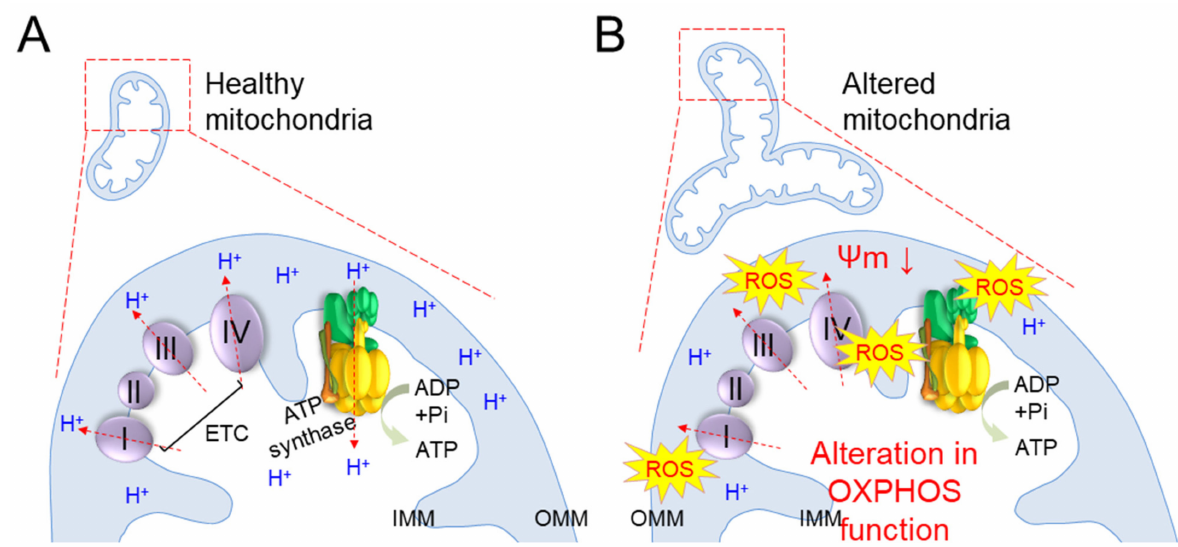
Figure 2. Schematic representation of basic mechanisms of senescence-induced mitochondrial metabolic changes. ( A ) Adenosine triphosphate (ATP) production is accomplished by a sequential reaction called oxidative phosphoryla- tion (OXPHOS), which involves four electron transport complexes (ETC; complexes I through IV) and ATP synthase. During OXPHOS, the redox process of the ETC produces a hydrogen ion (H + ) concentration gradient, leading to the movement of H + from ATP synthase to the matrix to generate ATP. IMM: inner mitochondrial membrane; OMM: outer mitochondrial membrane. ( B ) During senescence, dysfunctional mitochondria produce excess reactive oxygen species (ROS), causing the unwanted oxidation of proteins involved in OXPHOS and impairment of their function. Thus, electron transport in the ETC is disturbed and electrons leak out of the ETC. Inefficient electron transport concurrently impairs proton transport through the IMM and dissipates ∆Ψ m, thereby reducing the efficiency of OXPHOS and accompanying a lack of ATP production. The leaked electrons also react with O 2 , generating excessive mitochondrial